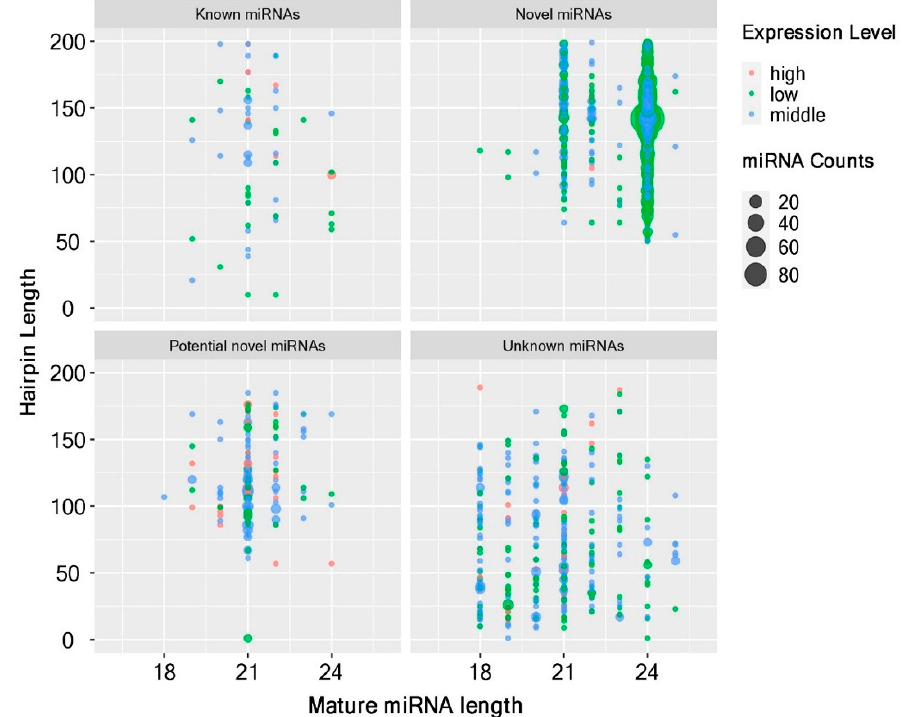
Figure 2. The four indicated groups of miRNAs identified from an incompatible interaction. The miRNA counts, the counts of miRNAs from miRBase. Expression level, low indicates <10, middle indicates >10, but less than average, high indicates over average. Hairpin length, pre-miRNA length.